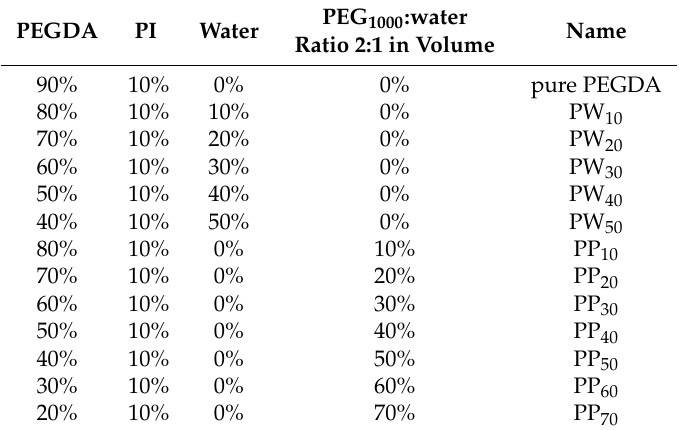
Table 1. Volume fraction of each component of the different photosensitive solutions used in this study. PEG 1000 PEGDA PI Water